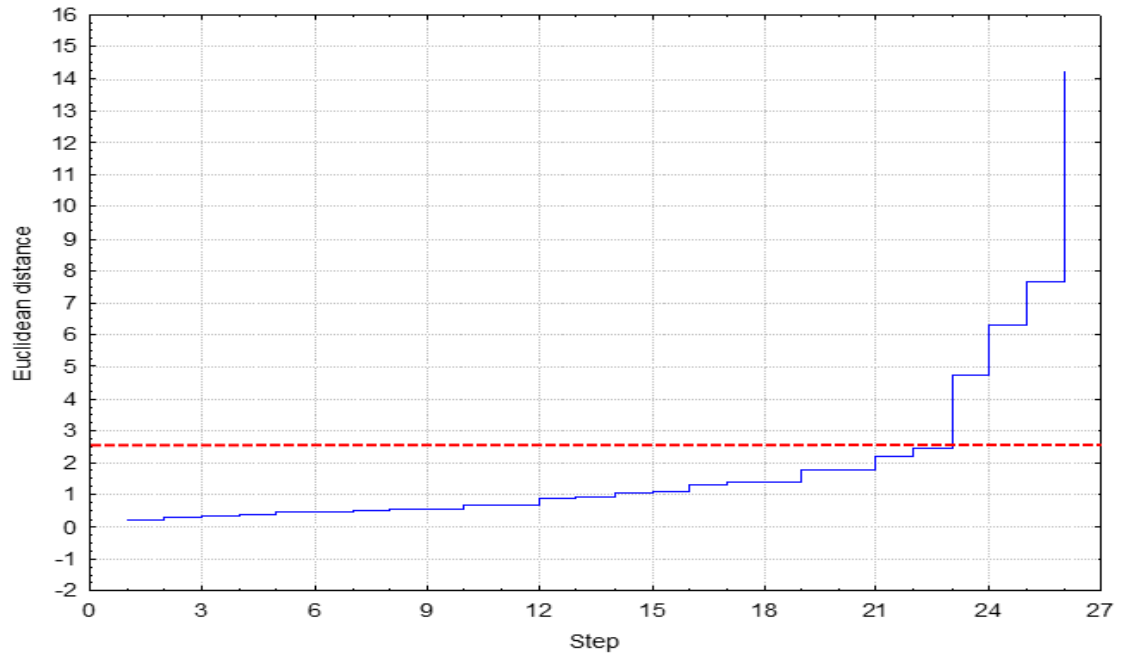
Figure 4. Graph of amalgamation schedule.